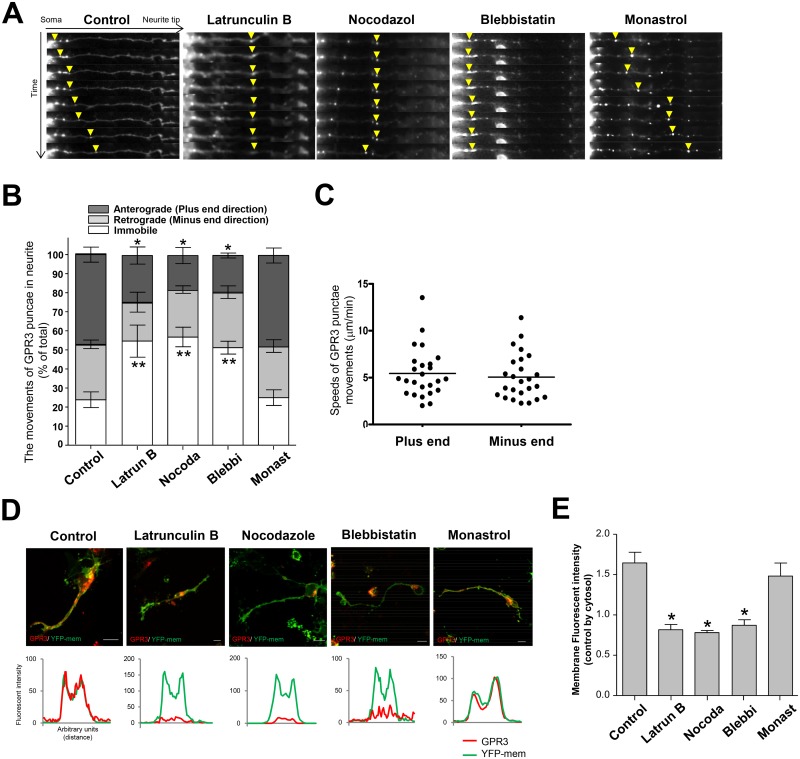
Fluorescence time-lapse imaging of a single GPR3-HT-expressing CGN.(A-B) The CGNs were transfected with the pGPR3-HT expression vector and were plated onto 0.03% PEI-coated plates. Forty-five hours after transfection, GPR3-HT was labeled with the TMR HaloTag ligand for 15 min. After three sequential washes in PBS, the cells were incubated with various inhibitors for another two hours. The cells were treated with 1 μM Latrunculin B, 3 μM Nocodazole, 50 μM Blebbistatin, or 2 mM Monastrol in the culture medium, respectively. As a control, a 1:1000 dilution of DMSO was added to the culture medium. The pGPR3-HT fluorescence in the CGNs was captured every 10 minutes using a fluorescent microscope. (A) Representative images of the CGNs from each condition were shown. The arrow indicates the GPR3 fluorescent puncta at each time point. Serial images were shown every 20 min. (B) The directions that the GPR3 puncta moved along the neurite were analyzed in each condition. The directions of puncta movement were divided into three groups: the plus end movement group, the minus end movement group, and the immobile group. The values were then expressed as the percentage of the number of puncta in each direction out of the total numbers of puncta. The numbers of puncta in plus end direction were significantly decreased when Latrunculin B, Nocodazole, Blebbistatin were included in the medium. The data represent the means ± SEM for each condition (n = 16). The asterisk (*) represents p < 0.0001 and the double asterisk (**) represents p < 0.05. (C) The speed of the GPR3 puncta were calculated from the time-lapse images. The mean speed of the GPR3 puncta in plus-end and minus-end directions were separately shown (n = 25). (D-E) The fluorescent intensity of GPR3 in the membranes at the neurite tips were evaluated with or without addition of various actin and tubulin inhibitors. The CGNs were co-transfected with pGPR3-HT and pYFP-mem. Twenty-four hours after transfection, some groups were treated with inhibitors as described above. Forty-six hours after transfection, the cells were labeled with the TMR HaloTag ligand for 2 hours. The cells were then fixed and the fluorescent images of GPR3-HT and YFP-mem were captured using a fluorescent microscope from the cells in each condition. The fluorescent intensity of GPR3 in the membranes at the neurite tips were evaluated by the line profiling method (detailed in the Materials and methods). (D) Representative images of the CGNs and the line profiling analyses from each condition were shown. (E) The fluorescent intensities of GPR3-HT in the plasma membrane and cytosol at the neurite tips were compared for each condition. The values were then expressed as the ratio of the fluorescent intensity at the plasma membrane to the cytosol at the neurite tips. The data represent the means ± SEM for each condition (n = 7). The asterisk (*) represents p < 0.0001.